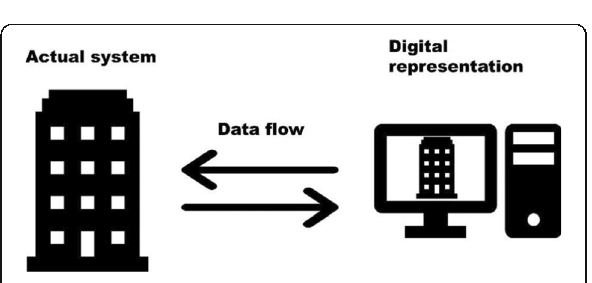
Fig. 9 (Abstract P8). A conceptual illustration of a digital